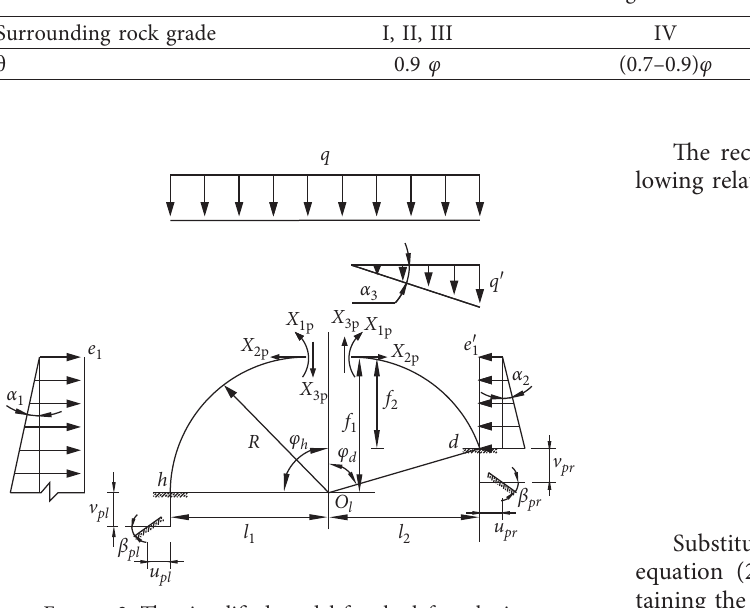
Table 2: The θ values for different grades of surrounding rock